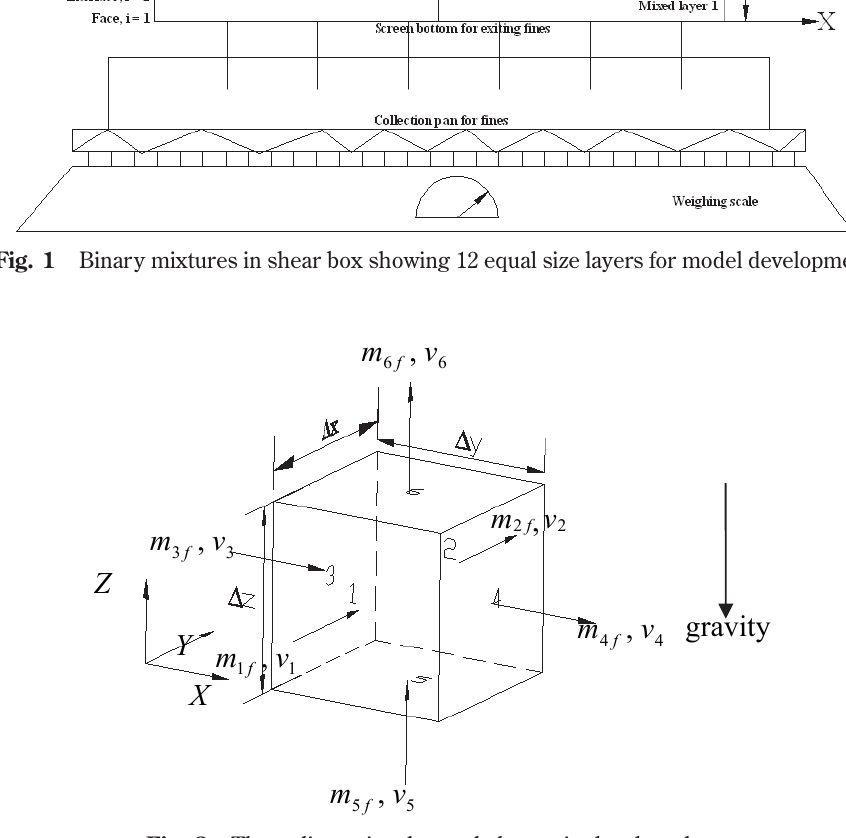
Fig. 2 Three-dimensional mass balances in the shear